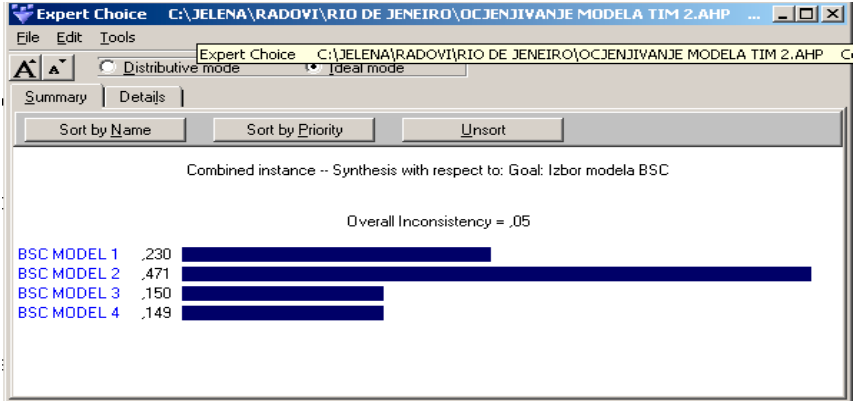
Figure 8. Results of evaluation of the BSC models obtained by Team 2 using the AHP method. J. Mar. Sci. Eng. 2019 , 7 , x FOR PEER REVIEW